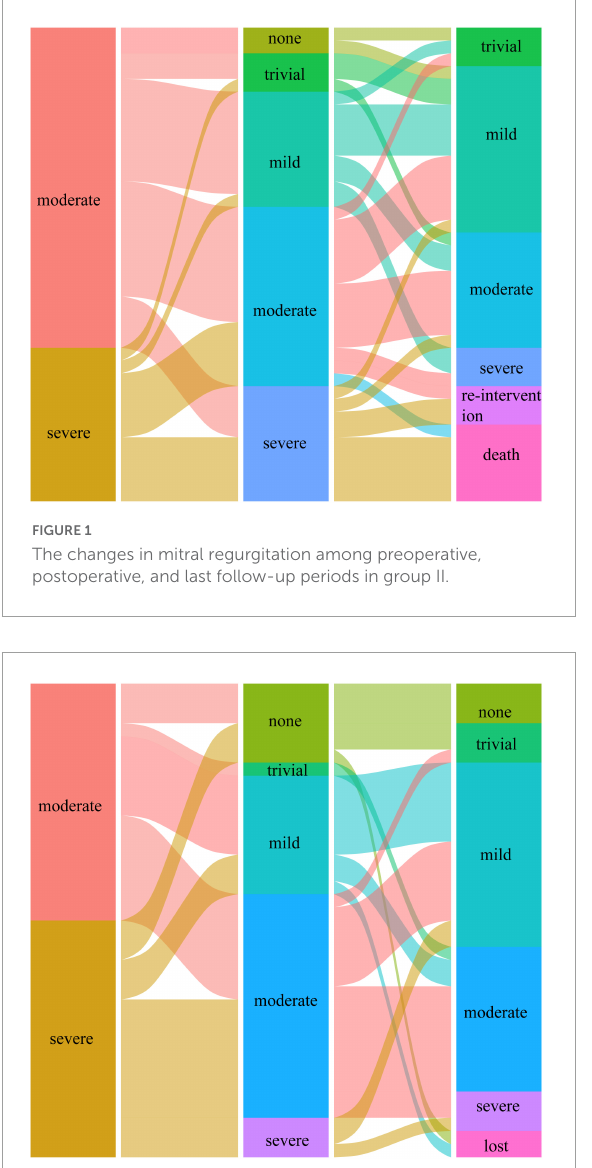
FIGURE2 The changes in mitral regurgitation among preoperative, postoperative, and last follow-up periods in group III.